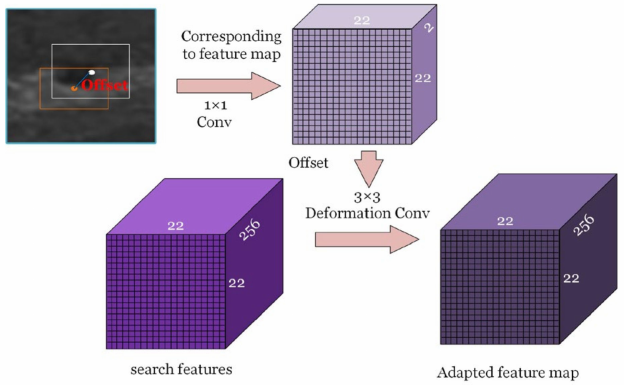
Figure 9. Adapting the feature map guided by anchors.